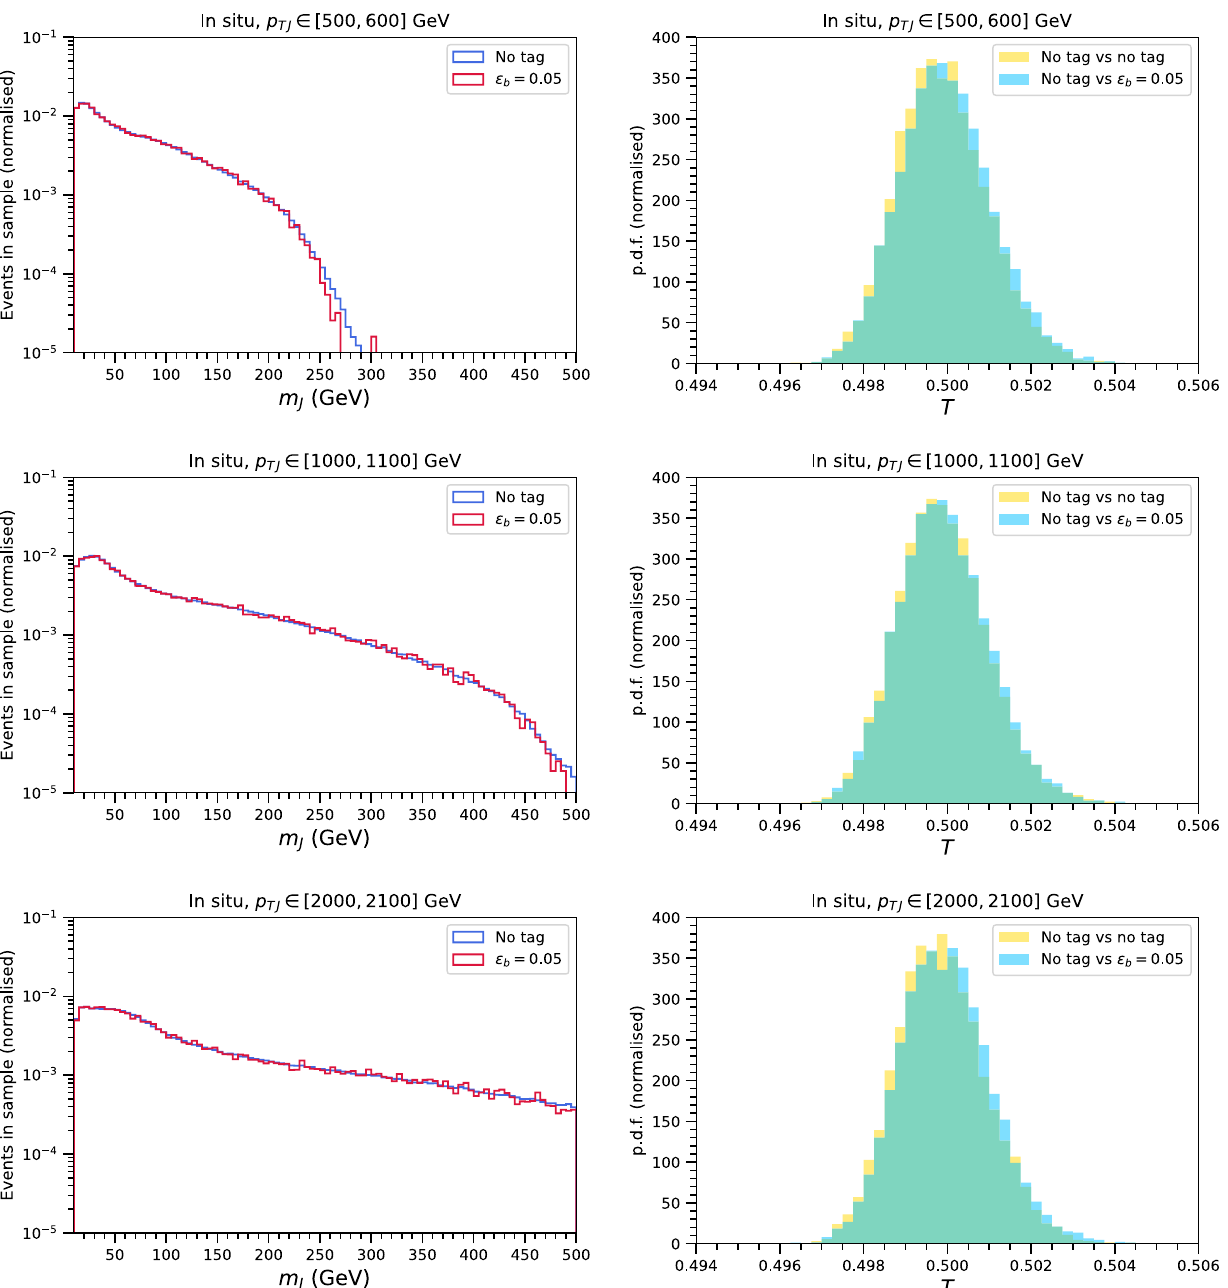
Fig. 8 Left:JetmassdistributionforQCDjetsinthreenarrow p T sam- ples, before tagging and after the application of the GenT x tagger and in-situ mass decorrelation with ε b = 0 . 05. Right: Probability density